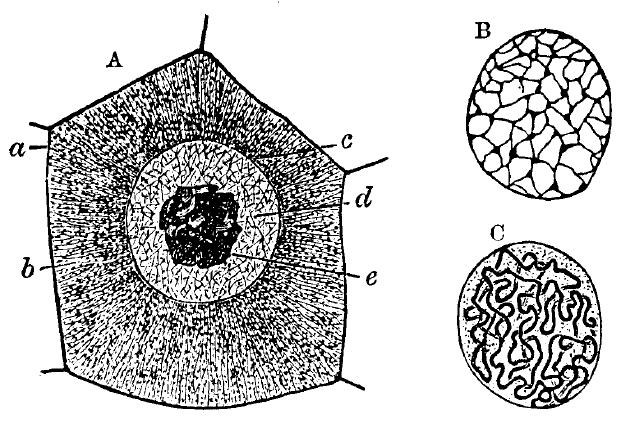
Figure 1 - A drawing from the early 20th century (Thomson, 1992, The Illustrated Chambers’s Encyclopaedia , Vol. 3, p. 49), showing the structure of the cell (A), and two possible chromatin arrangements in the still (inter- phase) nucleus: a network (B) or a continuous thread